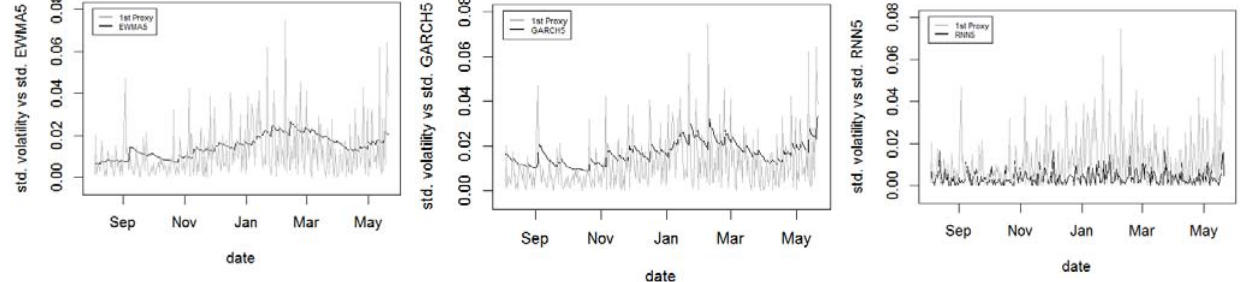
Figure 1. Out of sample standard deviation of realized volatility (1st proxy) vs standard deviation of 5 days ahead volatility forecasting of EWMA, GARCH and RNN model.